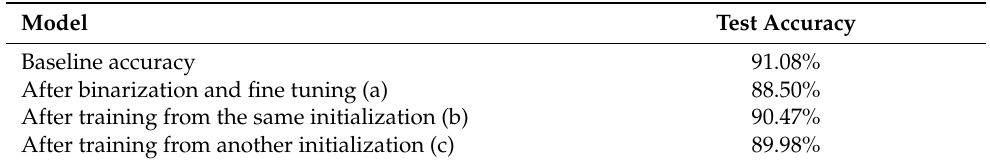
Table 6. Shortcut freezing experiment on